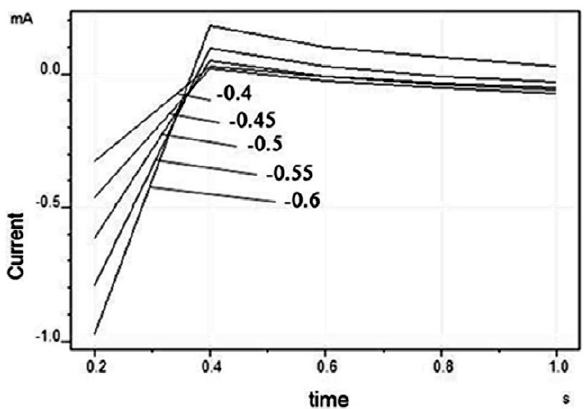
Fig. 6. Current-time curves of the electrodeposition of iron on Pt in the electrolyte of the 0.1 Fe(NO 3 ) 3 · 9H 2 O + CH 2 OH-CH 2 OH com- position at room temperature and different deposition potentials: -0.4; -0.45; –0.5; –0.55; and –0.6 V vs.